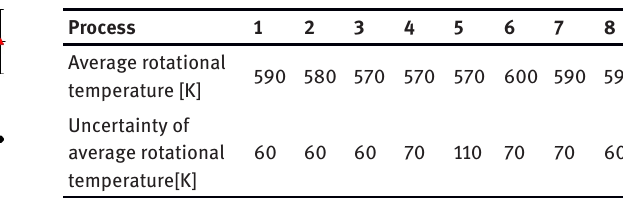
Figure 2: Time dependence of sample temperature. Samples treated at effective power of 100 W (left) and samples treated at effective power of 200 W (right). Table 2: Values of average rotational temperature and its uncertainty.